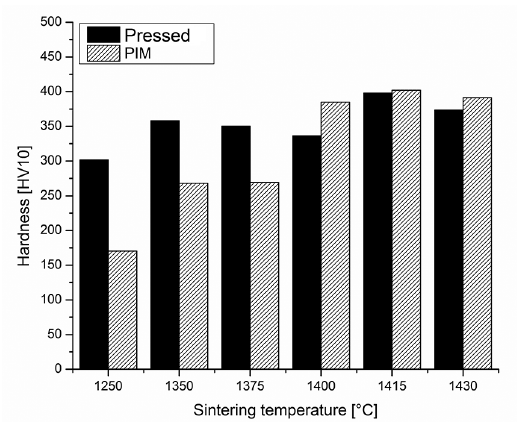
Figure 9. Hardness of pressed and injection molded samples after sintering at temperatures between 1250°C and 1430°C.